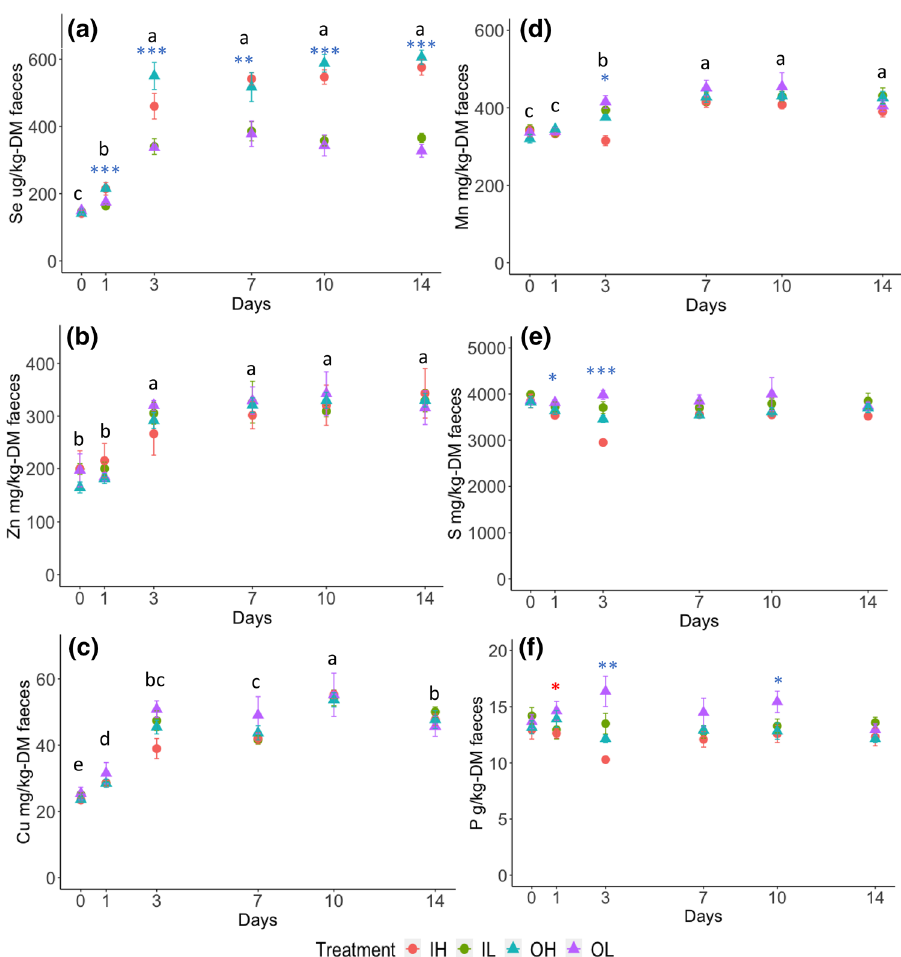
Figure 2. The concentrations of micronutrients and macronutrients in the faeces of sheep during the supplementary period. ( a ) Se (μg kg −1 DM) in faeces ( b ) Zn (mg kg −1 DM) in faeces ( c ) Cu (mg kg −1 DM) in faeces ( d ) Mn (mg kg −1 DM) in faeces ( e ) S (mg kg −1 DM) in faeces ( f ) P (g kg −1 DM) in faeces. The error bars are the standard errors (n = 6) of the samples. The colour of the symbol: ‘ * ’, ‘ * ’, ‘*’ represents the significant effect from supplement form (F1), supplementary dose (F2), the interaction of F1 and F2, respectively. The number of starts ‘*’, ‘**’ and ‘***’ indicate statistical significances of ANOVA test at p-value < 0.05, < 0.01, and < 0.001, respectively. The lowercase English letters represent the statistical results of post-hoc LSD test of temporal effect following a significant result of ANOVA